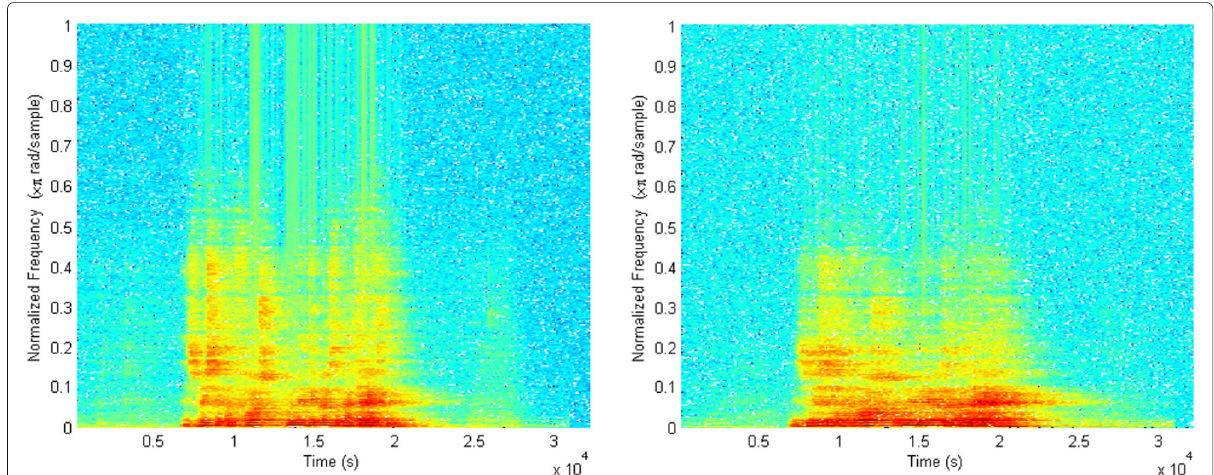
Fig. 4 Motivation for the spectrogram texture smoothness feature of Section 5.1.4. Left: spectrogram from a microphone located inside the active speaker room (bedroom in the apartment of Fig. 1). Right: spectrogram from a microphone outside it